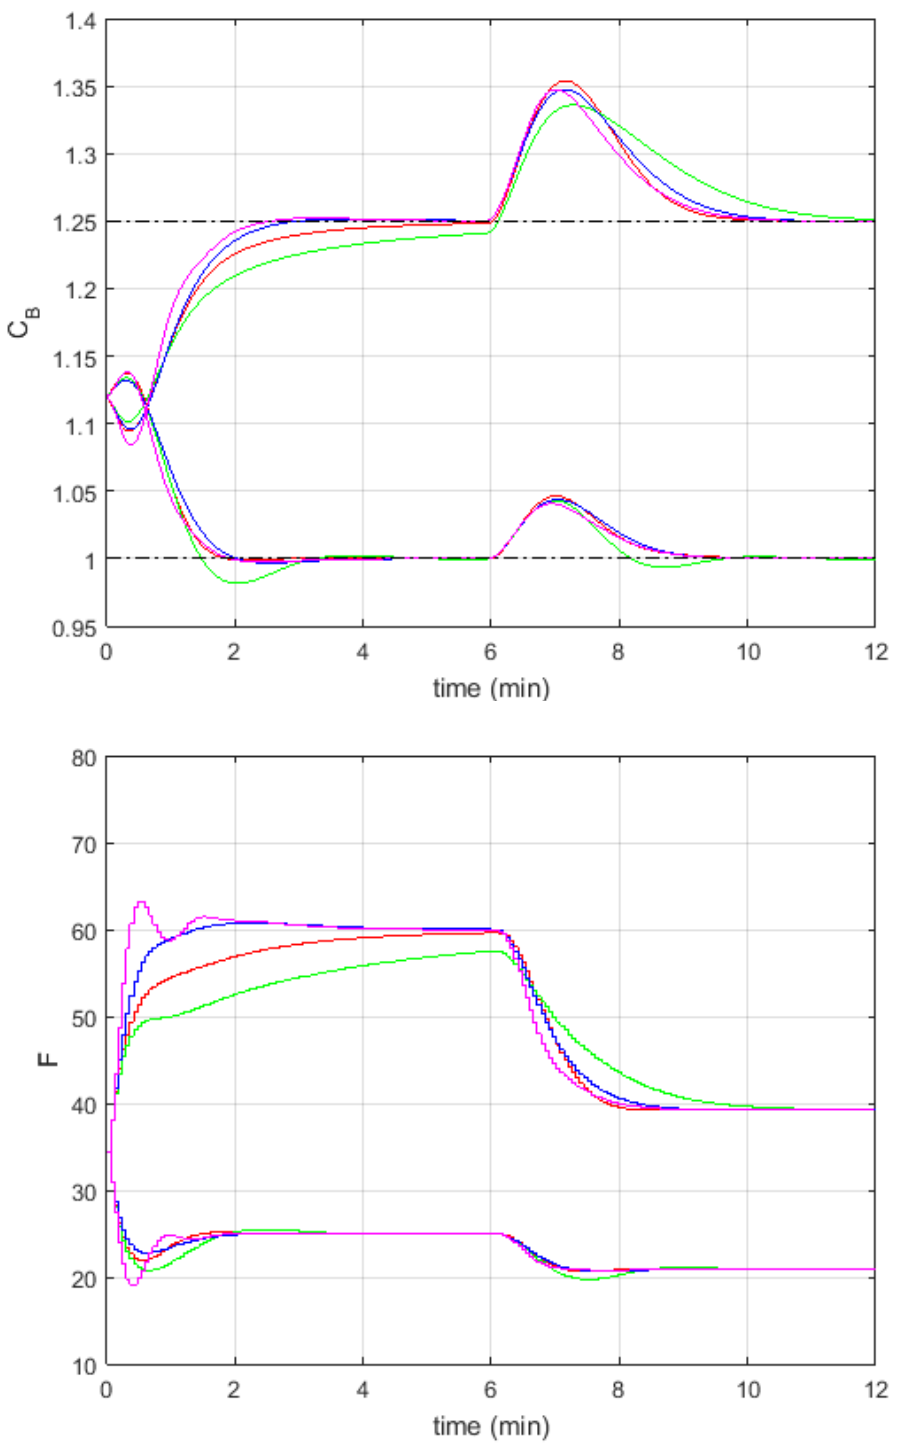
Figure 3. Responses of the control system to changes in the setpoint to C B 1 = 1 mol/L and C B 2 = 1.25 mol/L and to the change of the disturbance by 10% in the 6th minute of the experiment; λ = 0.001; Nonlinear Model Predictive Control (NMPC)—red lines, linear MPC (LMPC)—green lines, fuzzy MPS (FMPC)1—blue lines, FMPC2—magenta